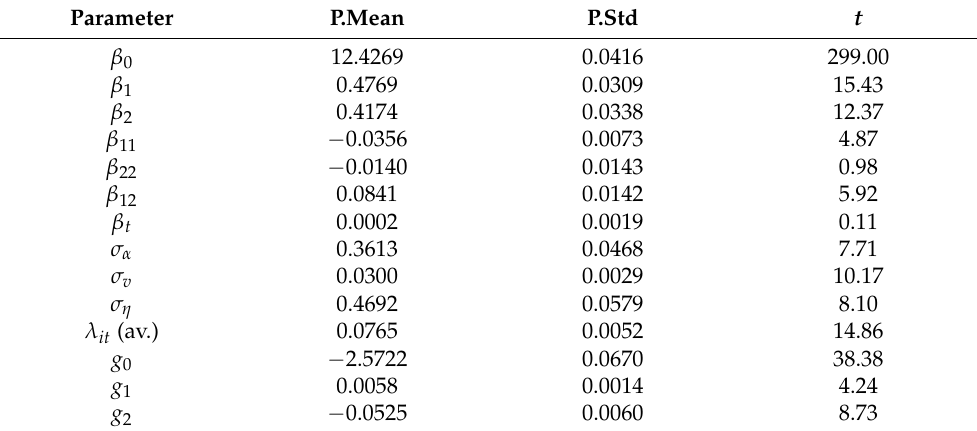
Table 1. Results based on the model without TPES (Equation (4)).